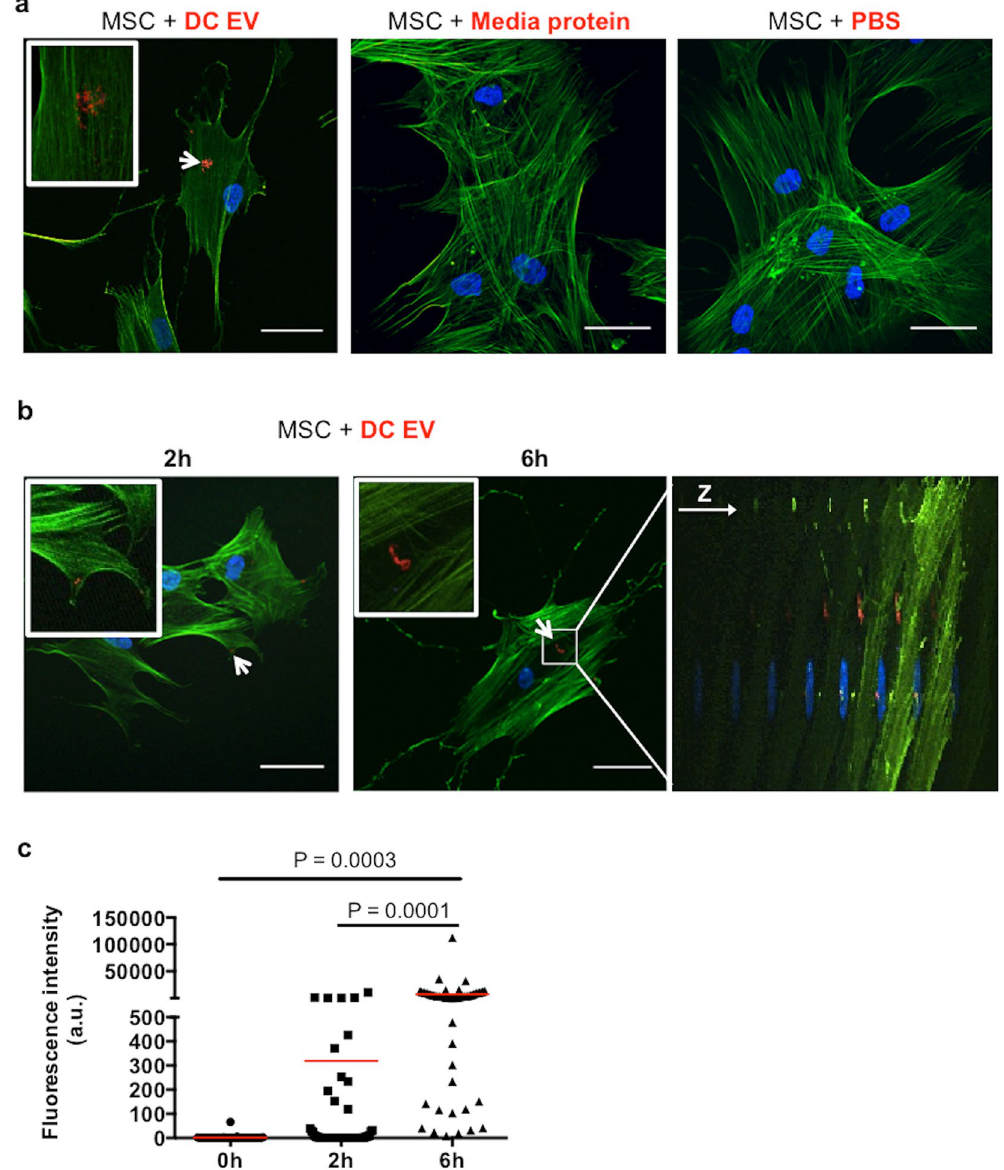
Figure 2. DC-derived EV are internalized by MSC. DC-derived EV were labelled with the lipophilic dye PKH26 before being co-incubated with MSC. Cells were labelled for actin cytoskeleton in green and nuclei in blue. ( a ) MSC with internalized red-labelled EV after 6 h of co-incubation (left panel). Specificity of EV labelling and internalization were accessed adding to MSC protein pellets of ultracentrifuged cell-free media (middle panel) or PBS (right panel) red-labelled as for EV, with no red staining detected. ( b ) MSC with internalized red-labelled EV after 2 h (left panel) and 6 h (middle panel) of co-incubation. Right panel shows the z-axis of an image stack, at 6 h. White arrows point to internalized EV, which are highlighted in picture insets. Z-stacks of images were acquired by laser scanning confocal microscopy and processed on Fiji software. Scale bar: 50 μ m. ( c ) Quantification of DC-EV internalization by measuring the fluorescence levels (a.u. = arbitrary units) of the red channel in cell ROIs previously defined according to phalloidin-AF488 staining. Red dash represents the mean and p-values are indicated as determined by 2-way ANOVA, followed by uncorrected Fisher’s multiple comparisons